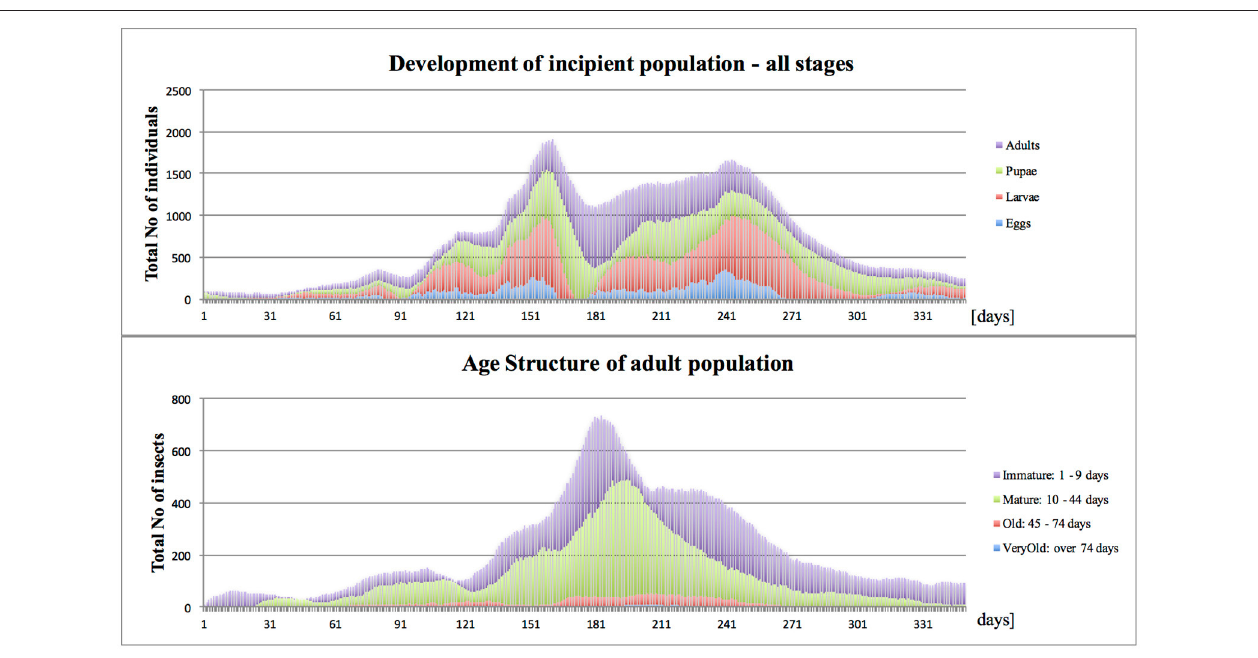
FIGURE 2 | On-farm propagule development in Mediterranean climate (Start, end of March; site, Farm Site; Med climate, average = 20 ◦ C, min = 11 ◦ C, max = 27 ◦